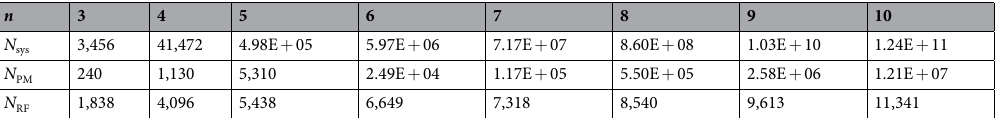
Table 2. Total numbers of trial structures for a peptide backbone with n AA residues required by the systematic search method ( N sys ), the path matrix method ( N PM ) 3 and the random forest assisted “divide and conquer” method ( N RF